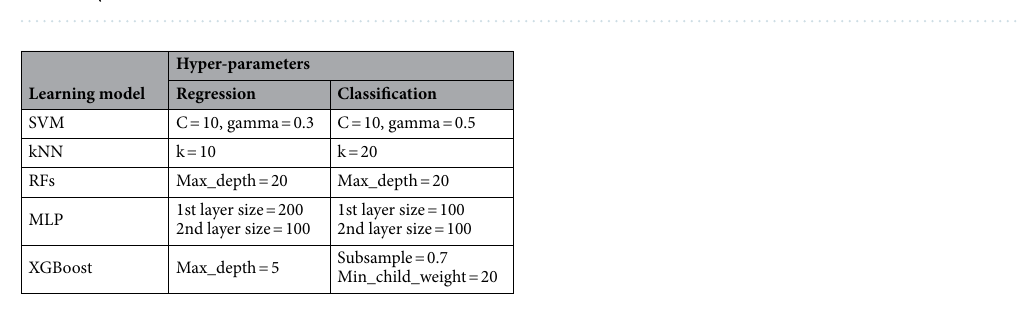
Figure 2. The influence of waveform design and ink property on drop formation and drop velocity. ( a ) Ink property changes with a waveform unchanged. ( b ) Amplitude of a waveform increased for a model ink. Scale bar: 100 μm.